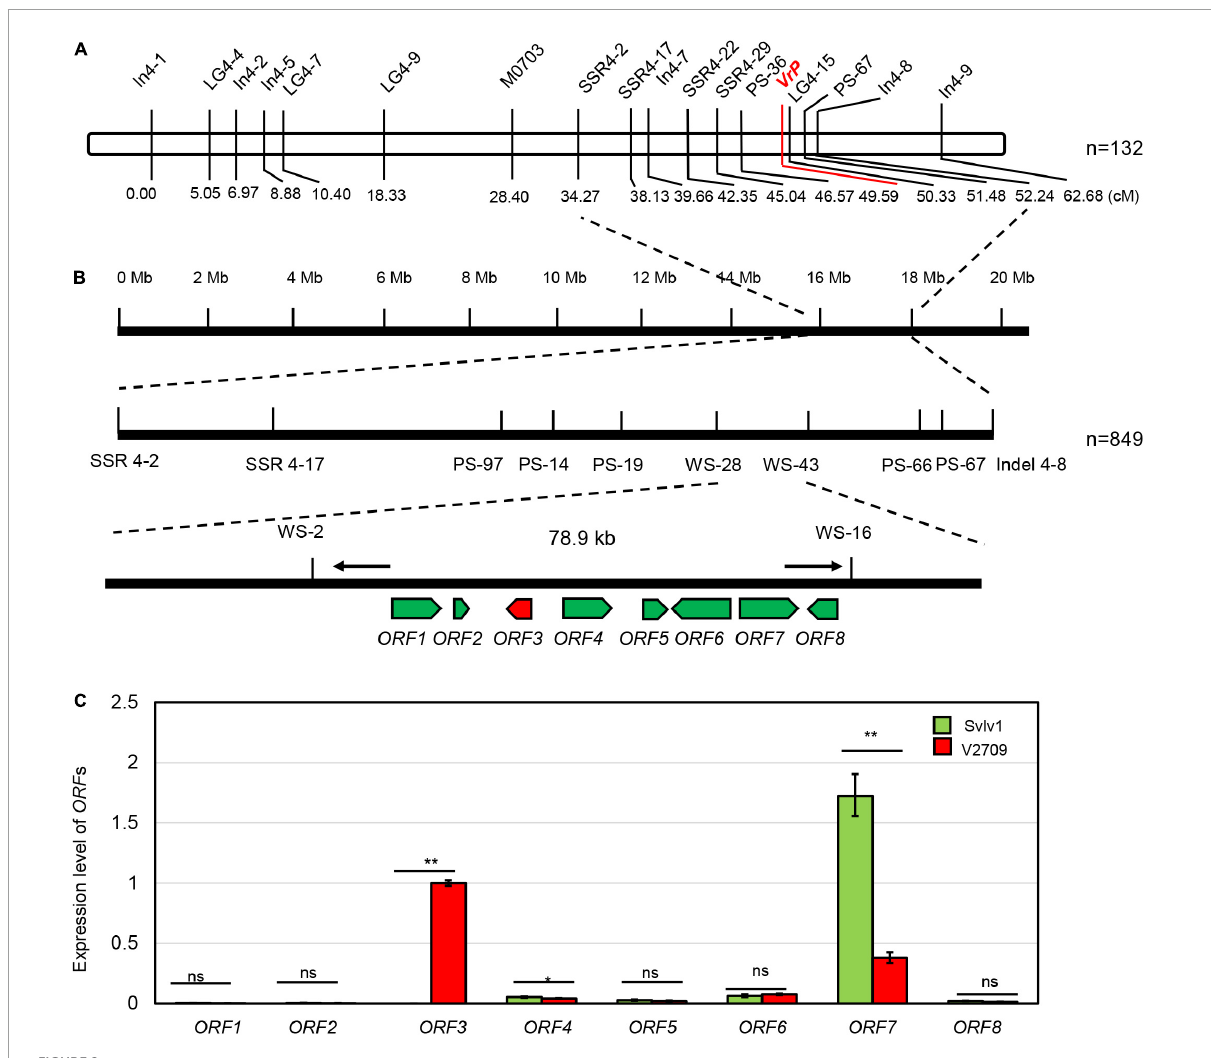
FIGURE2 Map-based cloning of VrP . (A) Linkage map showing the location of VrP . The number below indicates the marker position on the linkage map in centimorgan (cM) units, and n indicates the population size for linkage map construction. (B) The physical location of the VrP gene on chromosome 4 of mungbean. Molecular markers are labeled below the filled bars, arrows represent predicted genes, and n indicates the population size for mapping. (C) Expression analysis of ORFs in the mapping region of VrP from hypocotyls of V2709 and Sulv1. * and ** indicate a significant difference by Student’s t -test at P = 0.05 and P = 0.01, respectively, while ns indicates a non-significant